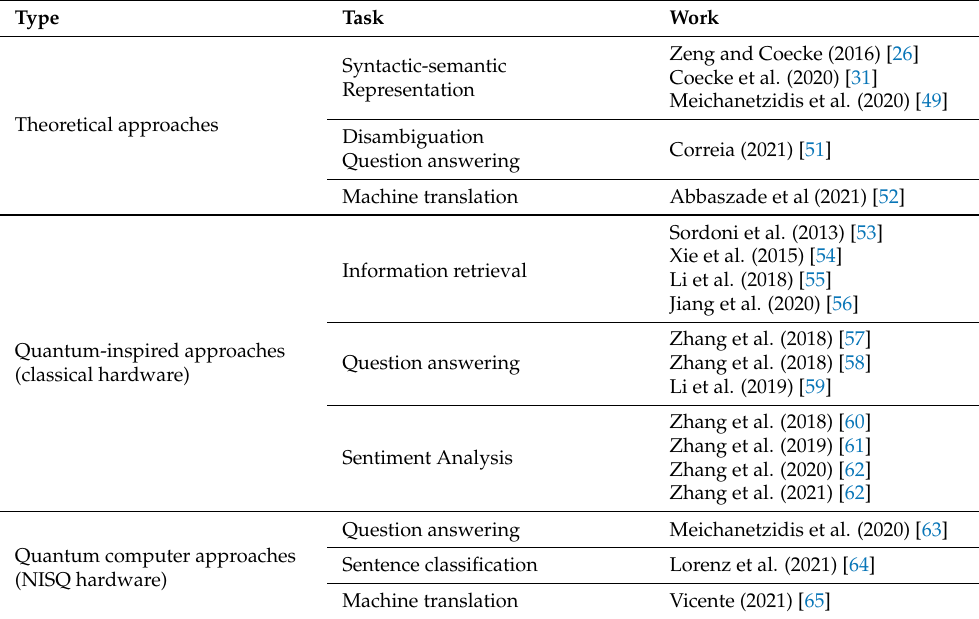
Table 1. Comparison of existing approaches divided by type (theoretical, really implemented on classical hardware and running on quantum hardware) and by NLP task on which they focused. Type Task Work